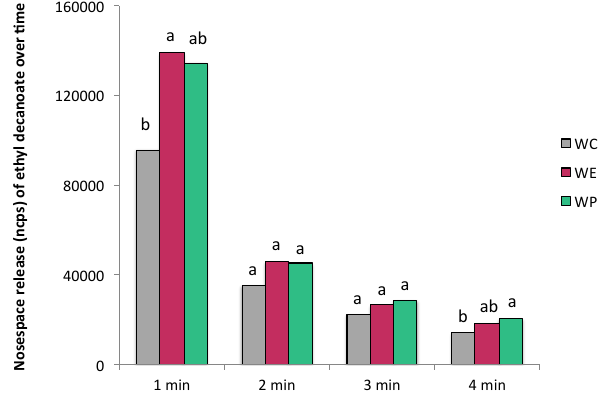
Figure 2. Mean values (ncps) of ethyl decanoate released in each of the wine types by PTR-ToF-MS. Data represent the AUC values determined in the subjects in each minute of analyses. Different letters denote statistical significant differences ( p < 0.05) from Tukey test.